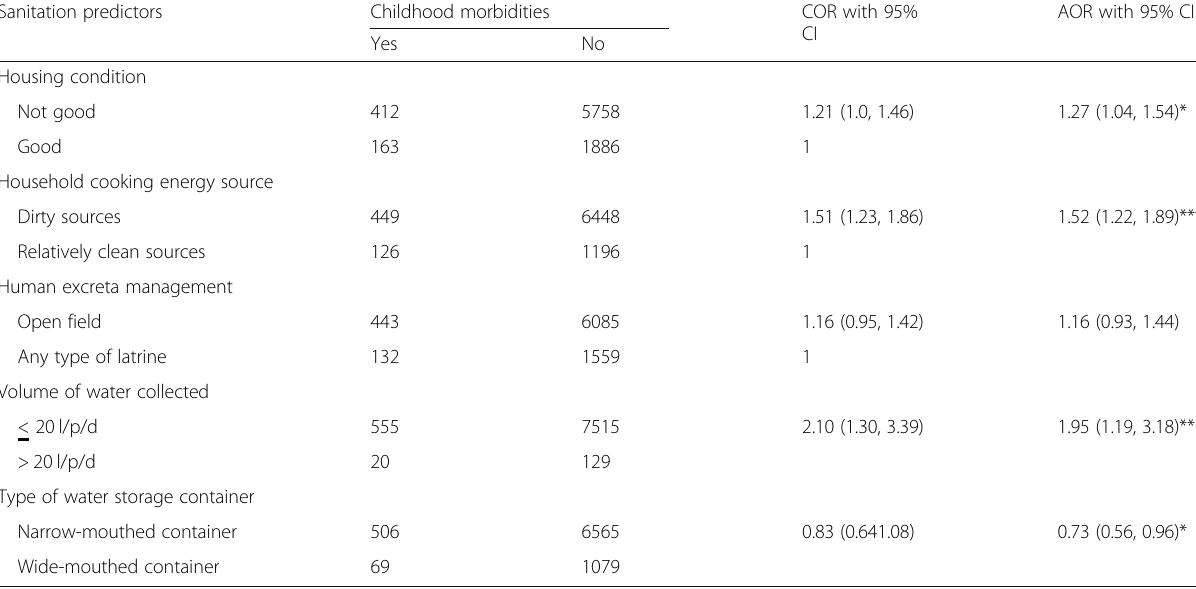
Table 5 Sanitation predictors of childhood morbidities among under-five children in DHDSS sites, Dabat, northwest Ethiopia, October to December 2014 Sanitation